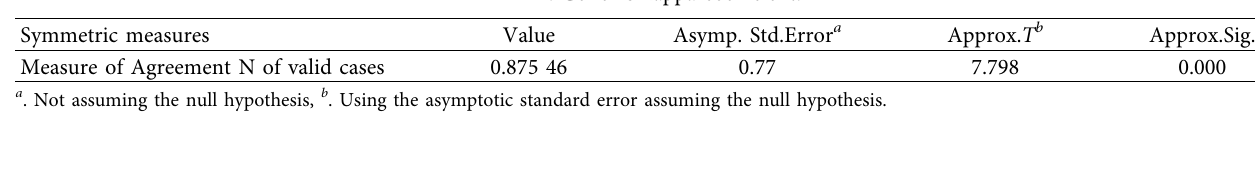
Table 3: Normality of score distribution of pre- and posttests.